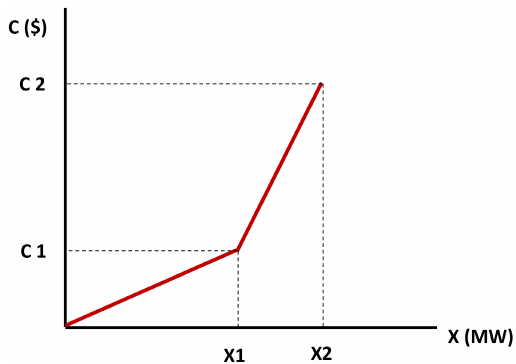
Figure 4. Variable cost allocation of